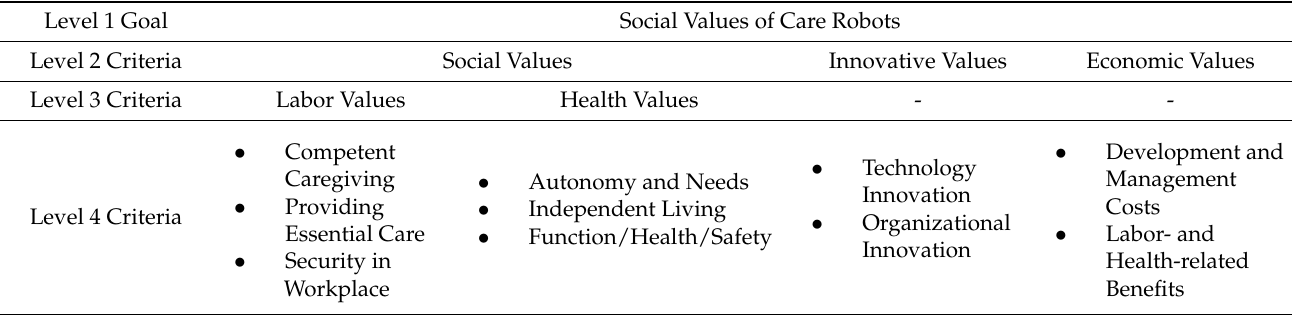
Table 1. AHP hierarchy with the associated goals, criteria, and